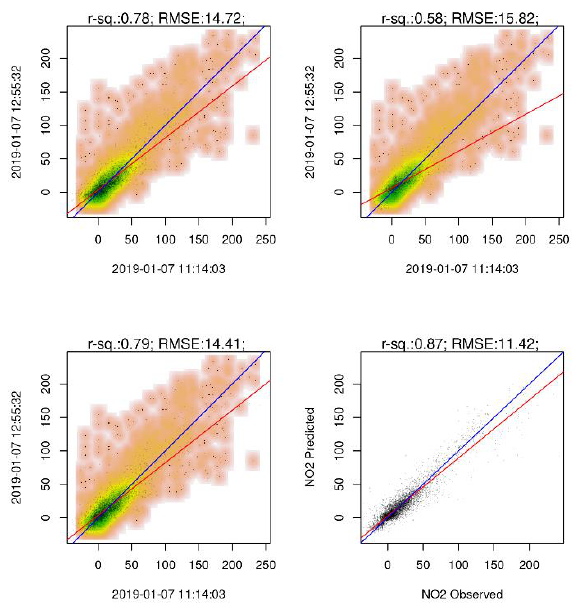
Figure 6. An example of results from two consecutive orbits. All values are in µmoles/m 2 . Blue line is 1:1 slope and red line is the regression fit. The regressions number references information in Table 2: top left is simple linear regression (1) between NO2 values between the two dates; top right is regression with a subset of cells with a cloud fraction less then 0.2 (2); bottom left is regression with the NO2 values of one date as dependent variable with four independent predictors (NO2 values of the other date, cloud fractions of both right is regression with random forest using the same set of independent predictors as the previous set (4).